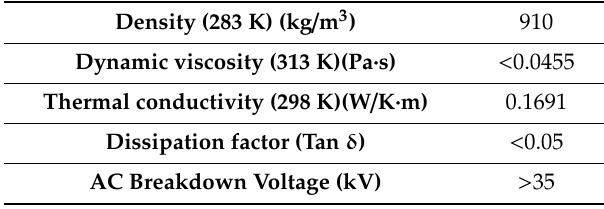
Table 1. Main properties of the vegetal base fluid.